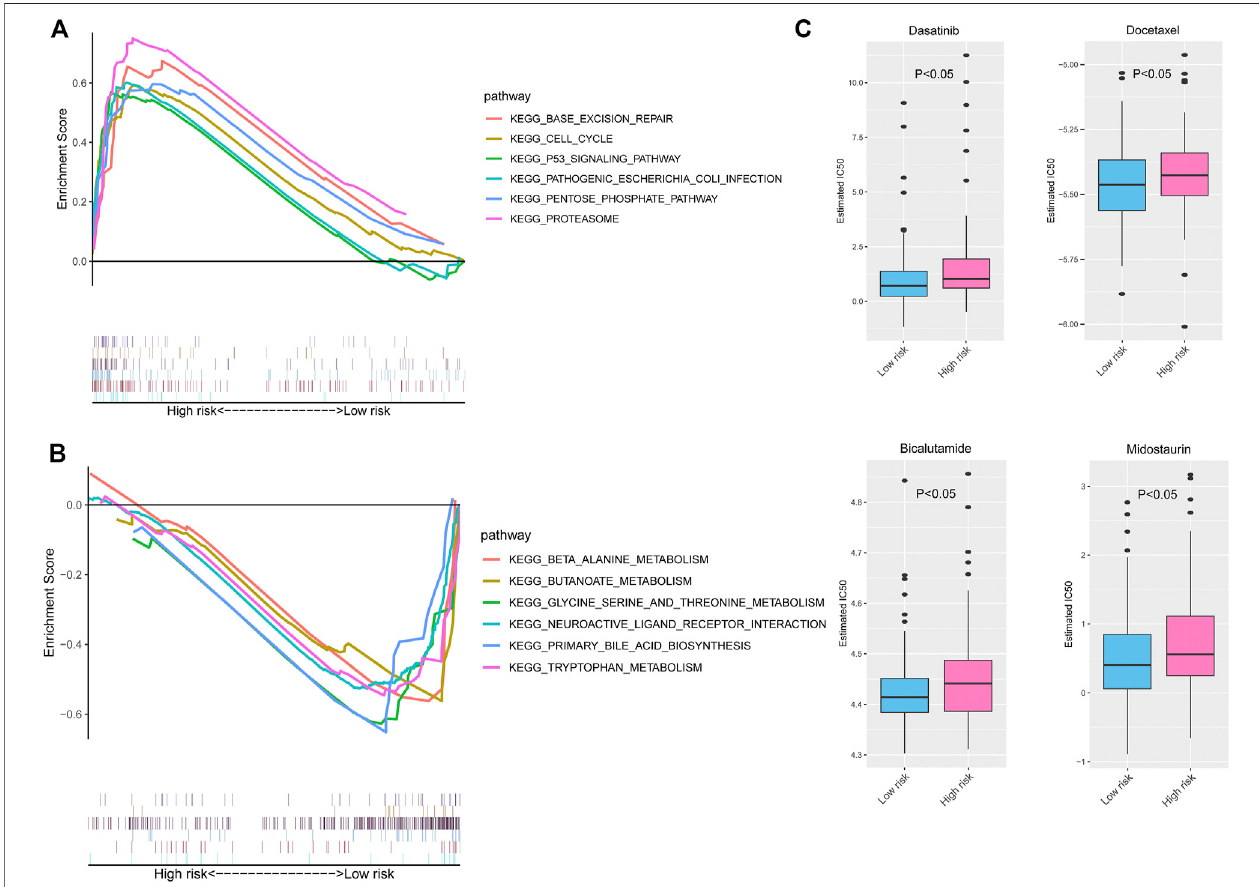
FIGURE 9 | GSEA and drug sensitivity prediction of the risk signature in PC. The enriched KEGG pathways in the high- (A) and low-risk groups (B) by GSEAs. (C) The estimated IC50 of chemotherapy response between the high- and low-risk groups. GSEA, Gene Set Enrichment Analysis; PC, pancreatic cancer; KEGG, Kyoto Encyclopedia of Genes and